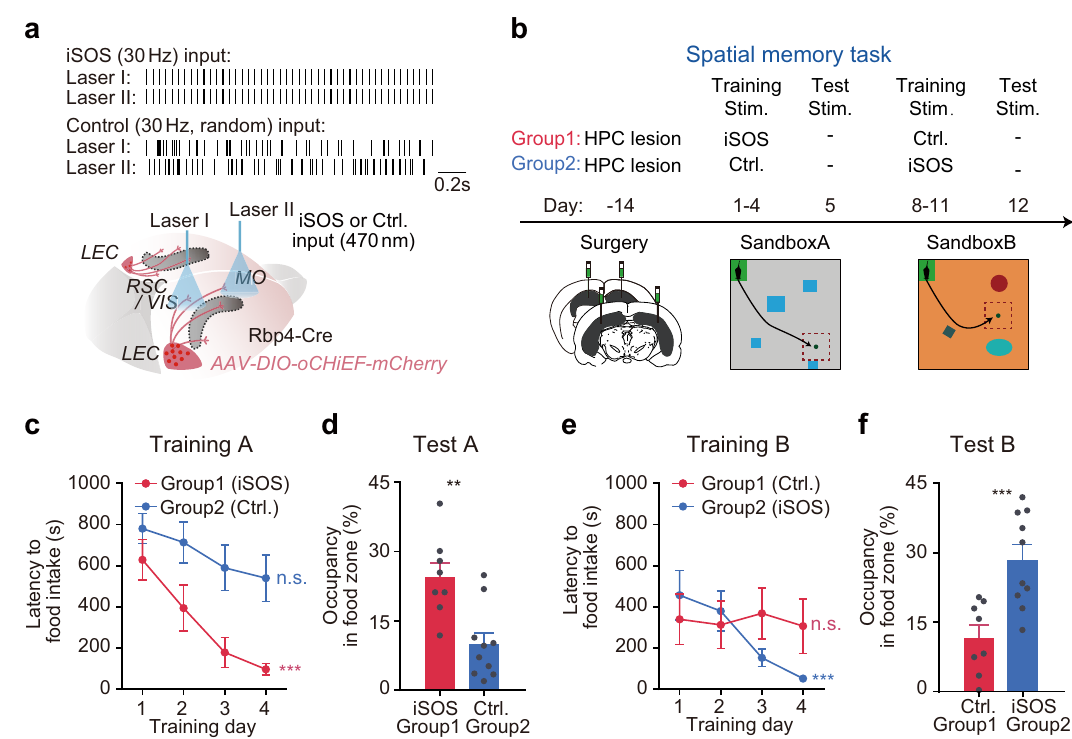
Fig. 4 Application of iSOS, but not asynchronous cortical axonal activation rescued spatial memory de fi cits in HPC-lesioned mice. a, b Scheme of the double dissociation experiment. a During training, LEC-axons in two cortical areas in HPC lesioned mice were activated by two independent fi bers with either synchronized signal (iSOS 30Hz ) or asynchronous signal (Ctrl. random pulses of each, same total pulse number). b HPC-lesioned mice were divided into two groups, both of which underwent the sequential maze tasks in two boxes in the same order. Group 1 mice were only applied with cortical iSOS during learning in the fi rst maze and group 2 mice were only applied iSOS in the second maze. c Learning curves for two groups in CtxA. (N Group1 = 8; N Group2 = 10; ANOVA, Time factor: F (3, 48) = 11.3, P < 0.0001; Group factor: F (1, 16) = 8.2, P = 0.0113; Interaction, F (3, 48) = 1.3, P = 0.2976; Bonferroni post-hoc test, P Group1:Day4 vs. Day1 < 0.0001, P Group2: Day4 vs. Day1 = 0.0689). d Probe trials of the two groups in CtxA (two-sided t -test, t (16) = 3.8, P = 0.0017). e Learning curves for two groups in CtxB (ANOVA, Time factor: F (3, 48) = 4.7, P = 0.0056; Group factor: F (1, 16) = 0.36, P = 0.5582; Interaction, F (3, 48) = 4.7, P = 0.0062; Bonferroni post-hoc test, P Group1:Day4 vs. Day1 > 0.9999, P Group2: Day4 vs. Day1 < 0.0001). f Probe trials of the two groups in CtxB (two-sided t -test, t (16) = 3.9, P = 0.0013). Each dot represents one mouse. Error bar shows lines shows